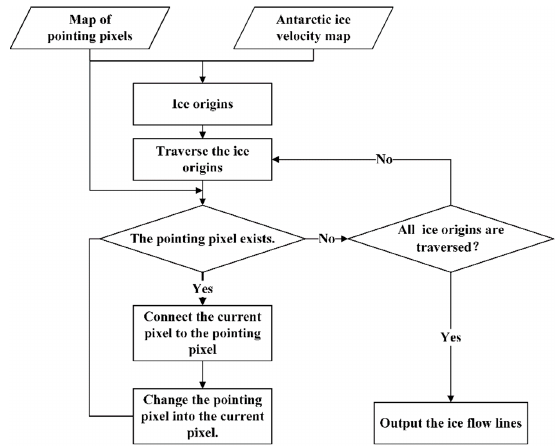
Figure 3. Flowchart of the Ice flow lines generation.